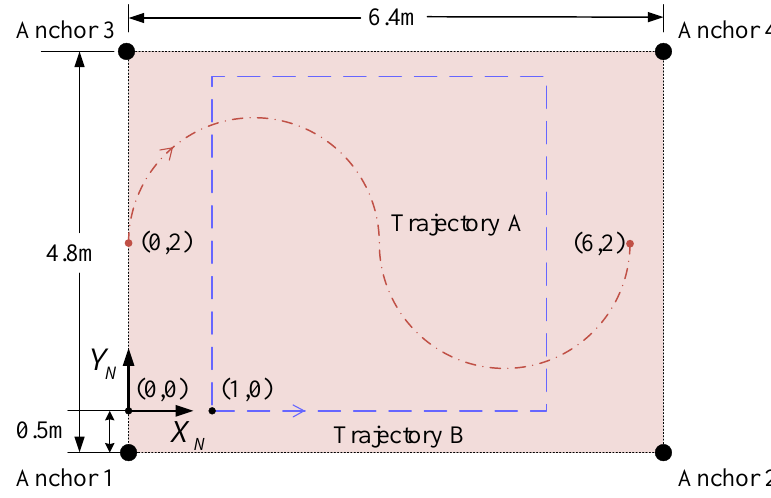
Figure 11. The reference trajectory of integrated positioning